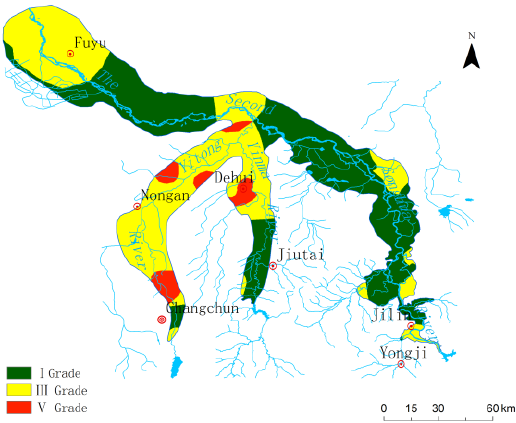
Figure 12. Distribution of water quality suitability in the core study area.